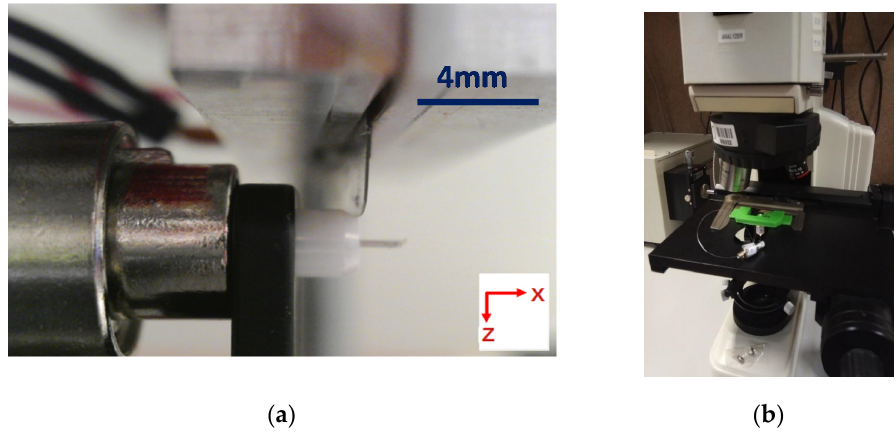
Figure 3. ( a ) Picture of the cleaver before stating the cleaving sequence. ( b ) Optical microscope with ferrule holder for characterizing the cleave. ferrule holder for characterizing the